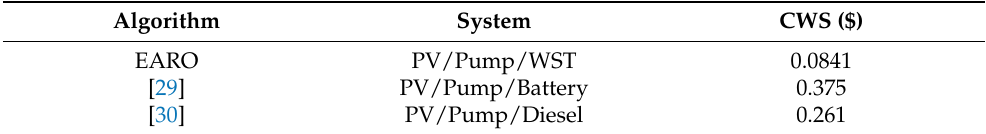
Table 17. Comparison of the EARO performance with previous